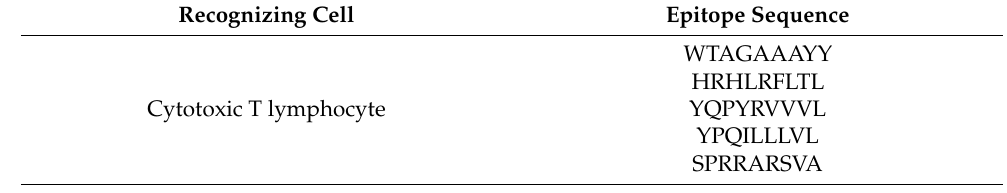
Table 1. Epitopes selected for vaccine construction.